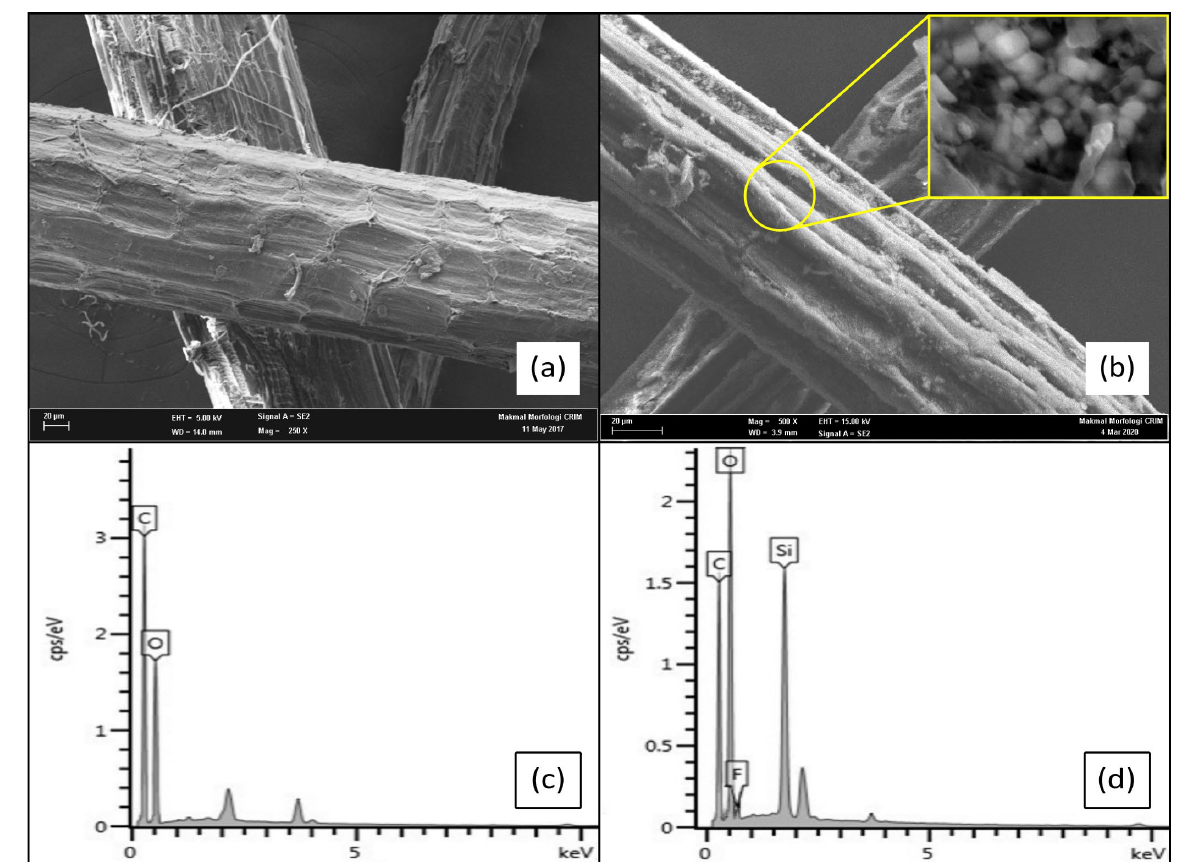
Figure 6. FE-SEM images and its corresponding EDX spectrum of ( a , c ) untreated STF ( b , d ) SiO 2 - PFOTS treated STF.